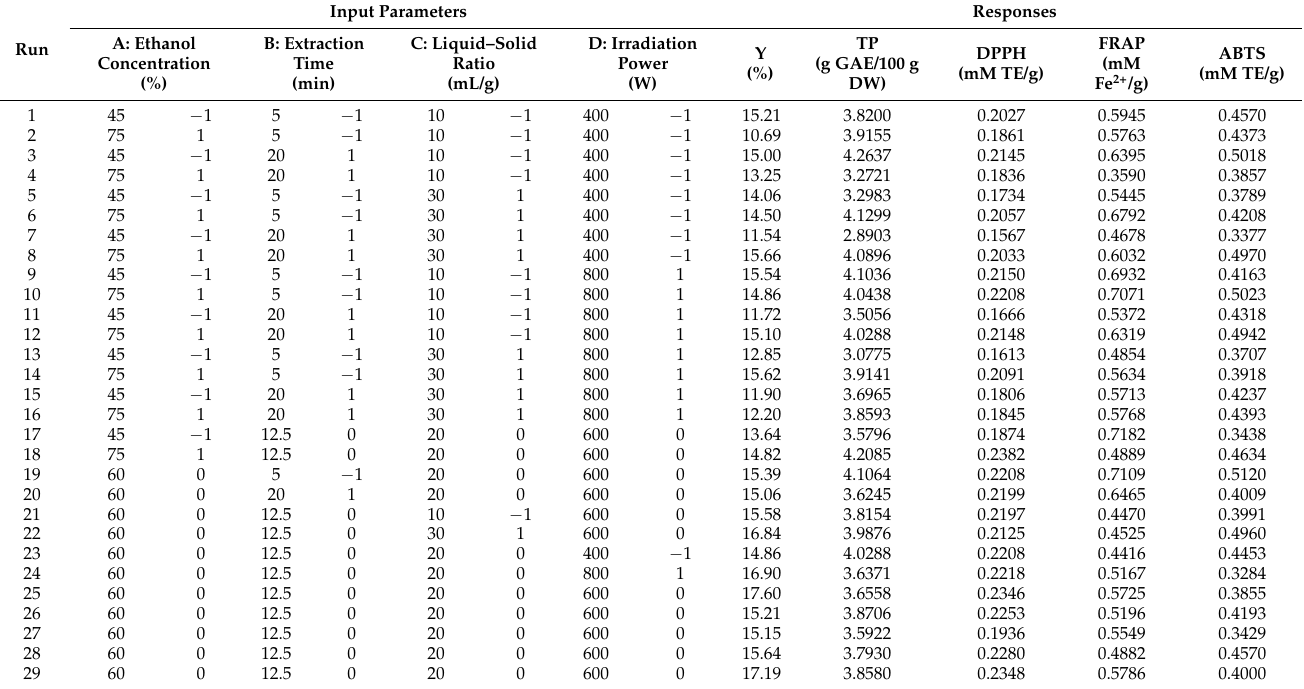
Table 1. Face-centered CCD with coded and actual values of input parameters and experimentally observed values of investigated